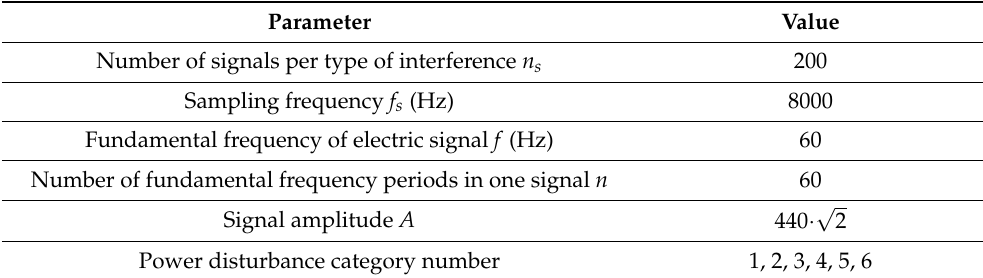
Table 3. Power disturbance parameters. Parameter Value Number of signals per type of interference n s 200 Sampling frequency f s